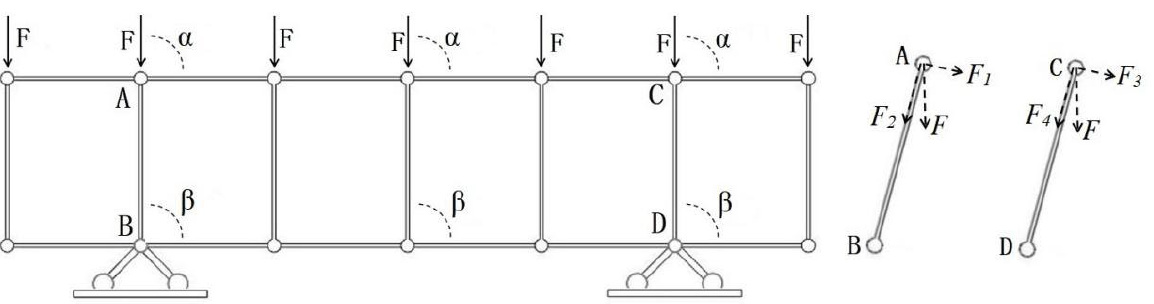
Figure 4. Force diagrams of the plane truss structure and two web members.